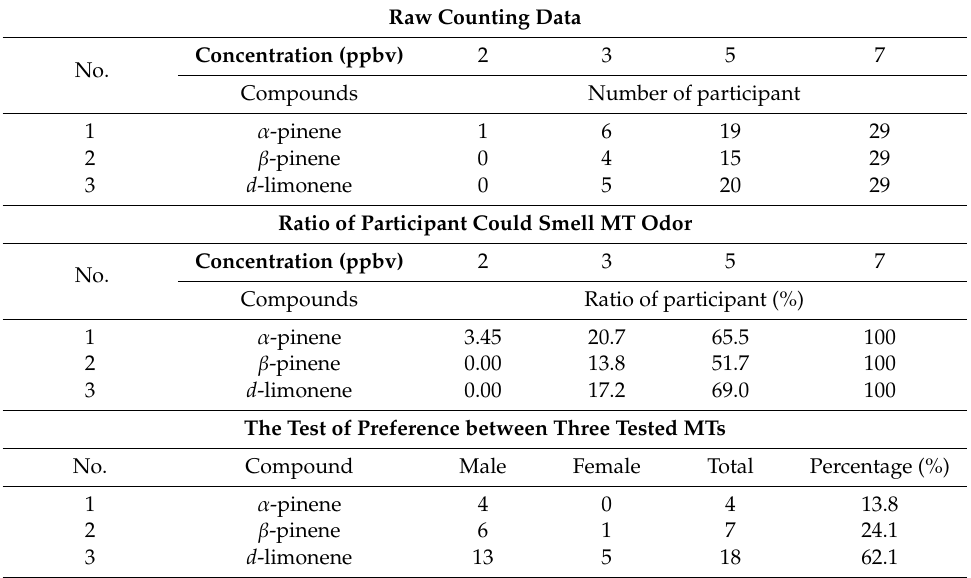
Table A1. Summary of MT olfaction tests at four di ff erent concentrations of each MT standard gas (Exp 1).